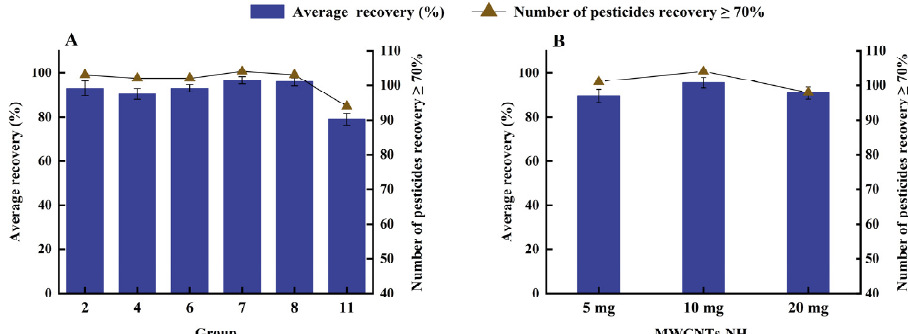
Figure 5. ( A ) Influence of the absorbent on the recoveries of pesticides from the spiked 100 µ g/kg mixed sample. ( B ) Influence of MWCNTs-NH 2 dosages on the recoveries of pesticides from the spiked 100 μ g/kg mixed sample.